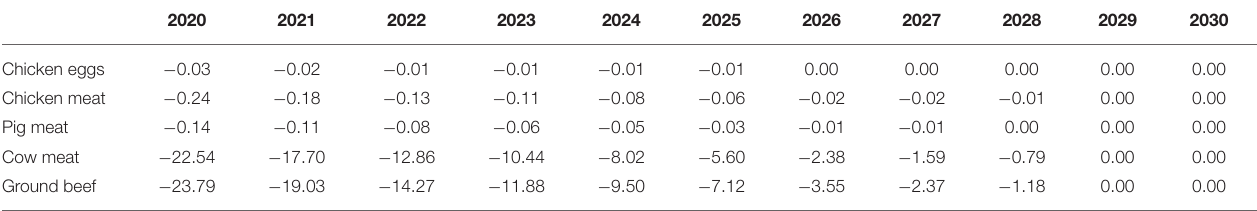
TABLE 6 | Scenario